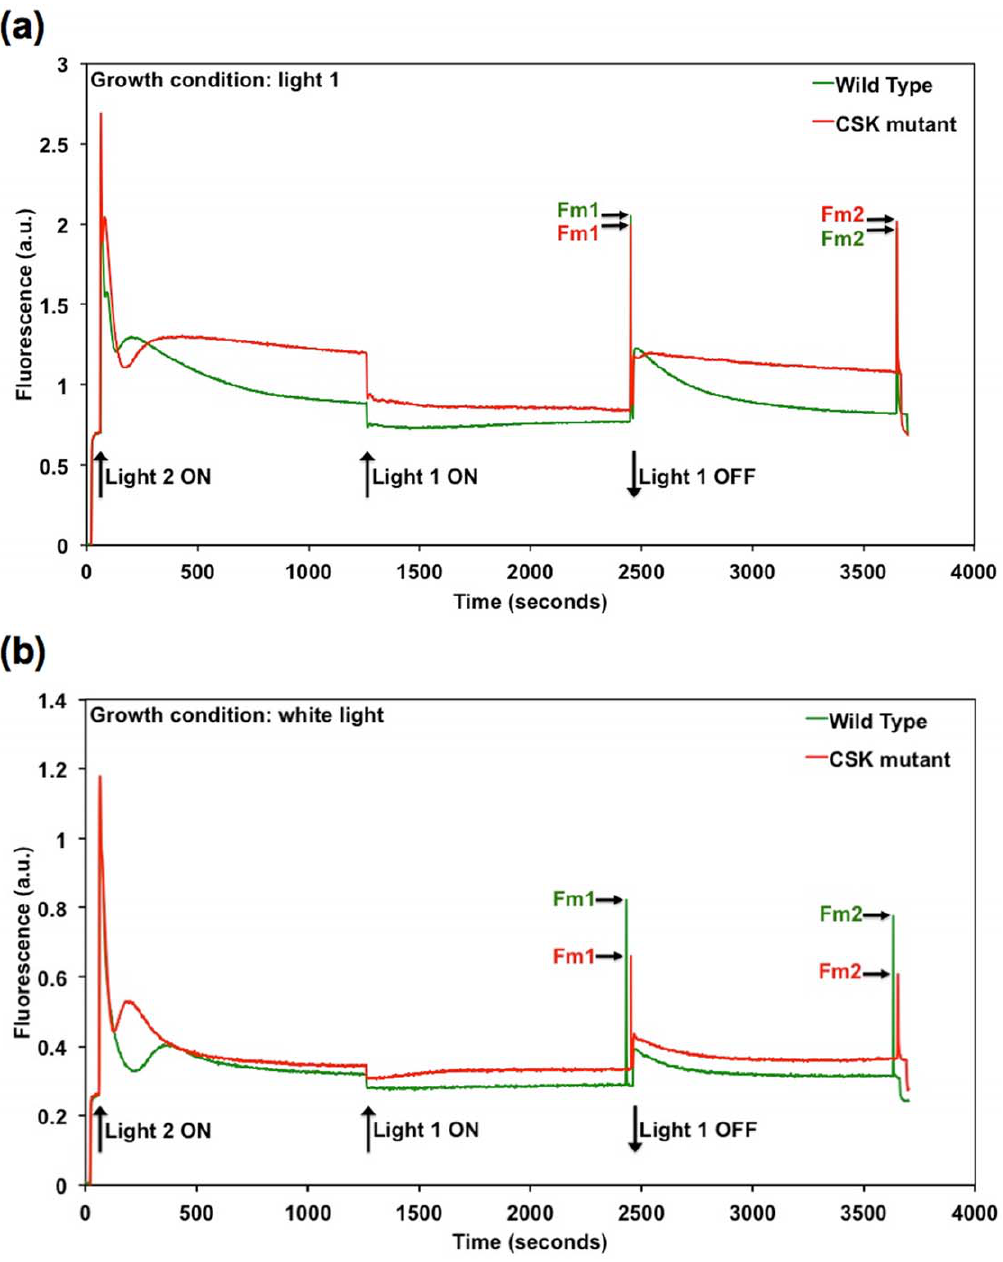
Figure 1. Chlorophyll fluorescence emission by leaves of Arabidopsisthaliana at room temperature. Two days of light 1 treatment (before monitoring the room temperature variable chlorophyll fluorescence) are assiciated with an apparent state transition minus phenotype in CSK mutants. Figure 1a shows the time-course of variable chlorophyll fluorescence emission from leaves of Arabidopsis thaliana , which were grown in light 1. Illumination with light 2, which is absorbed primarily by photosystem II, initially increases chlorophyll fluorescence emission. Fluorescence then decreases, and one component of the decrease is the removal of light-harvesting capacity from photosystem II during the transition to state 2. Addition of light 1, absorbed primarily by photosystem I, causes an initial decrease in fluorescence and then a slow rise, as the light-harvesting capacity of photosystem II increases during the transition to state 1. The slow components attributable to the state 2 and state 1 transitions are seen in the wild type, but are absent from the CSK mutant. Figure 1b shows fluorescence emission from white light grown plants. Fm 1 and Fm 2 are maximal fluorescence at state 1 and state 2 respectively. doi:10.1371/journal.pone.0026372.g001 initial effect of light 1 superimposition is accentuated in the CSK after light 1 superimposition, in the case of CSK mutant the mutant, which might indicate that the high reduction level of PQ steady-state level continues to drop slowly. The slow rise in pool observed under light 2 actinic illumination results only from fluorescence observed in the wild type was attributed both in part to oxidation of a fraction of PQ pool, in part to redistribution of PS I limitation of the linear electron transport chain of thylakoids. Moreover, while in the wild type there is a slow fluorescence rise LHC antenna, increasing the cross section of photosystem II